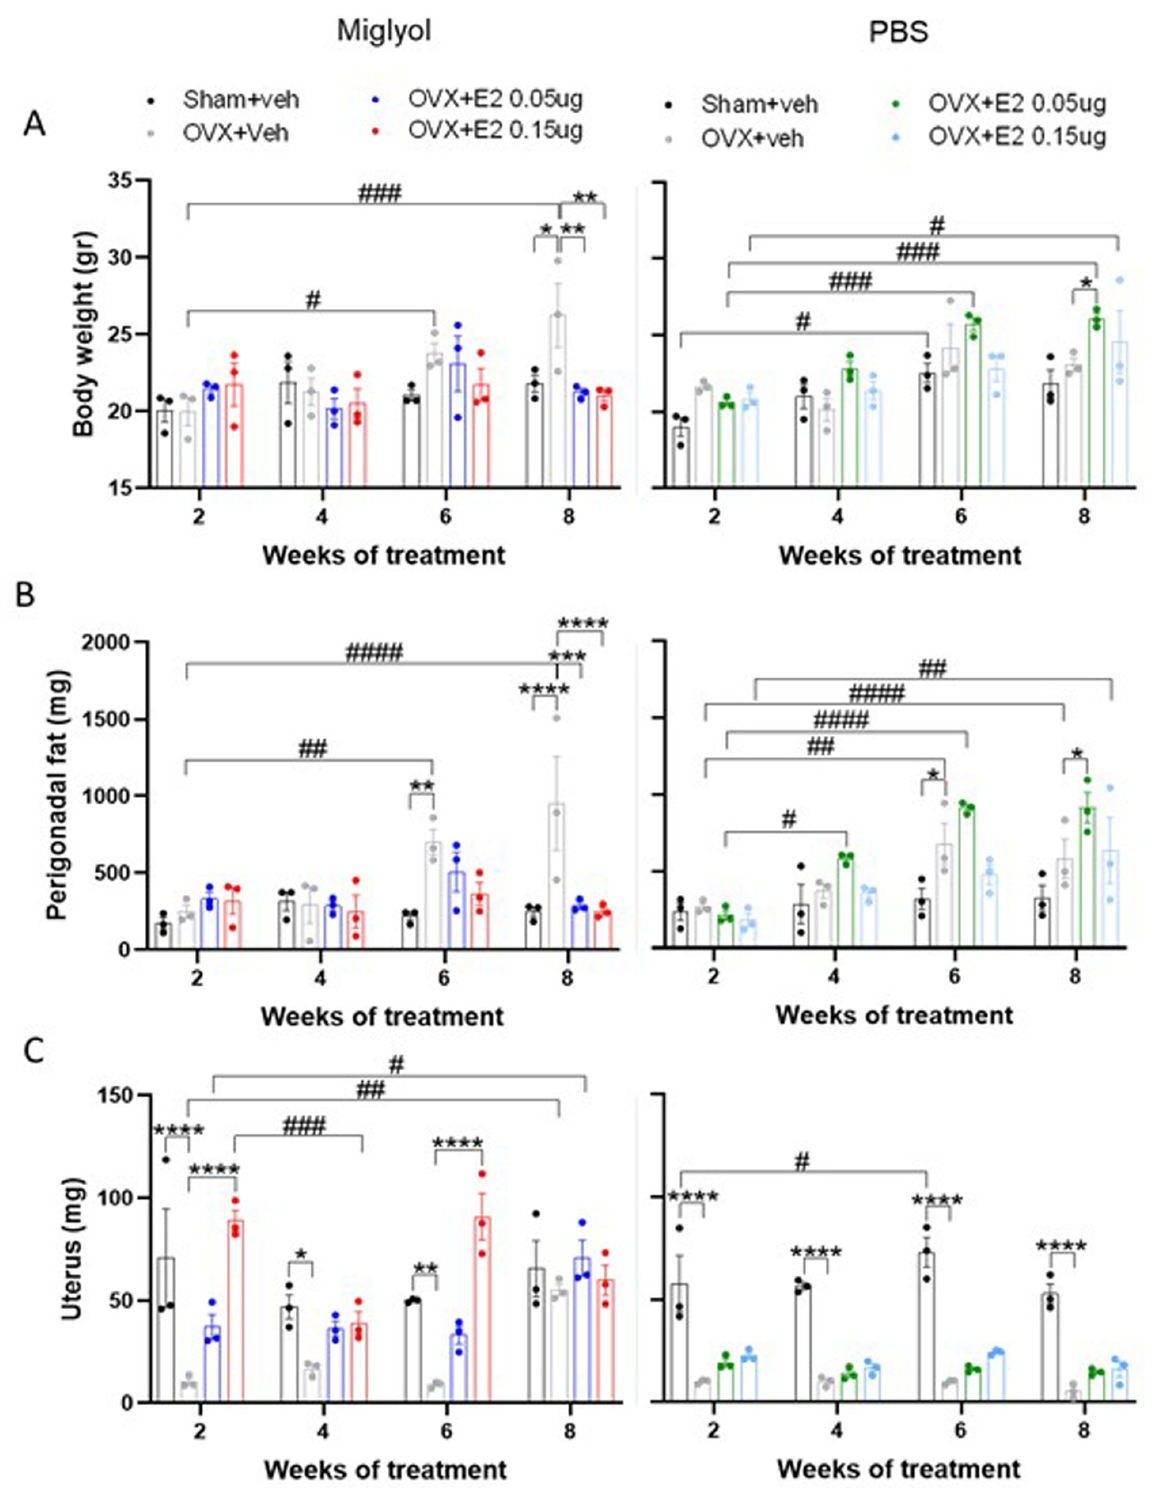
Figure 5. Body weights and weights of soft tissues. Mice were subjected to Sham or OVX surgery and treated with s.c. injections of vehicle (miglyol or PBS) or 17β-estradiol (E2; 0.05µg/mouse or 0.15µg/mouse) every 4 days. Experiments were terminated at 2, 4, 6 and 8 weeks after the start of treatments. Body weight ( A ), perigonadal fat ( B ) and uterus ( C ) weights were determined at sacrifice. Data are expressed as mean±SEM; n=3 for each experimental group. * statistical differences between sham+veh vs OVX+veh; or OVX+veh vs the E2 treatment groups; # statistical difference vs week 2 of the same treatment group. *or #, p<0.05; **or ##, p<0.01; ***or ###, p<0.001; ***** or ####, p<0.0001; Two-way ANOVA followed by Dunnet’s post-hoc test).